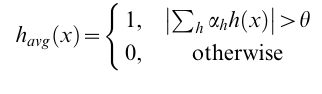
Figure S1 Distribution of prediction scores for + 1 (red curve), 0 (blue curve), 2 1 (green curve) examples. Figure S2 Scatter plot of true expression values versus prediction scores F ( x ). The scatter plot shows a high correlation between prediction scores ( y -axis) and true log expression values ( y